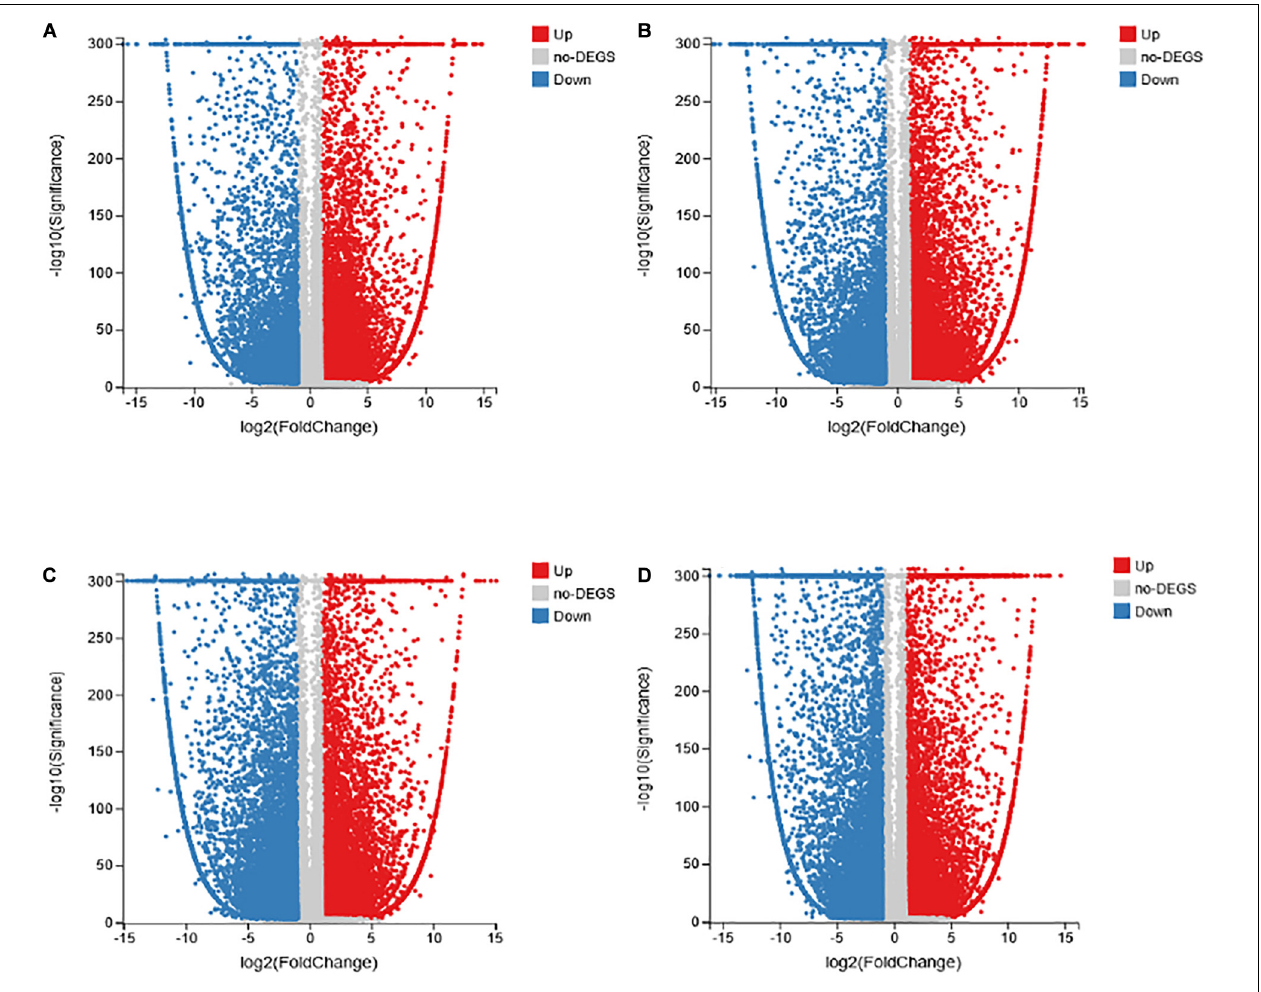
FIGURE 5 | Analysis of DEGs in common vetch in NM-AM (A) ; NM-NMP (B) ; AM-AMP (C) ; and NMP-AMP (D) . NM = uninoculated with S. tortuosa , AM = inoculated with S. tortuosa , NMP = NM inoculated with C. lentis , and AMP = AM inoculated with C. lentis . The x -axis represents the change in gene expression folds in different samples, the y -axis represents the statistical significance of the difference in gene expression changes in the sample; the red dot indicates the up-regulated gene with significant differential expression; the blue dot indicates the up-regulated gene with significant differential